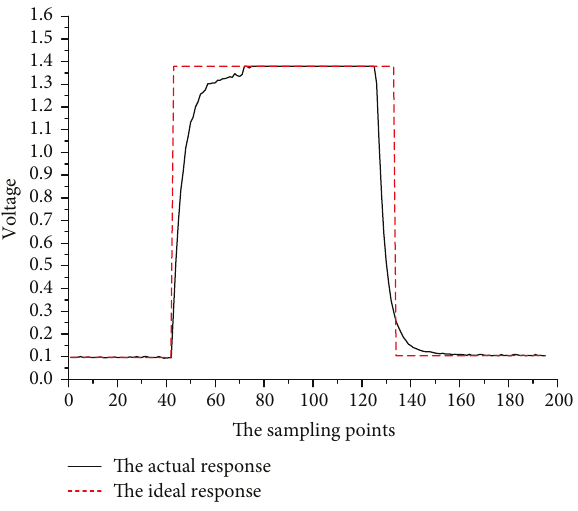
Figure 7: The sensor response process of the